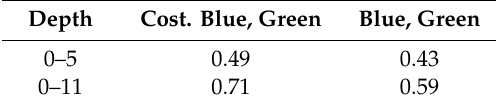
Table 2. MAD (m) of different depth ranges and band combinations for SDB with Stumpf’s model.